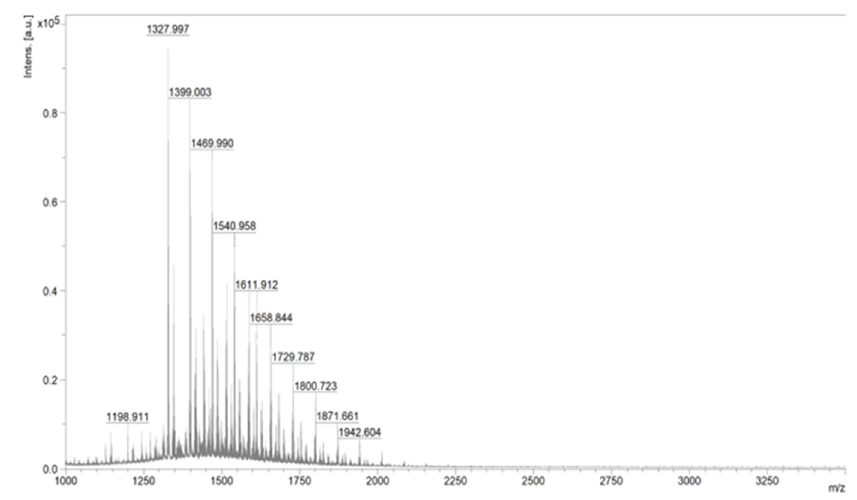
Figure 18. MS spectrum of the obtained polysaccharide–H-KRMVRISRSL-OH conjugate .